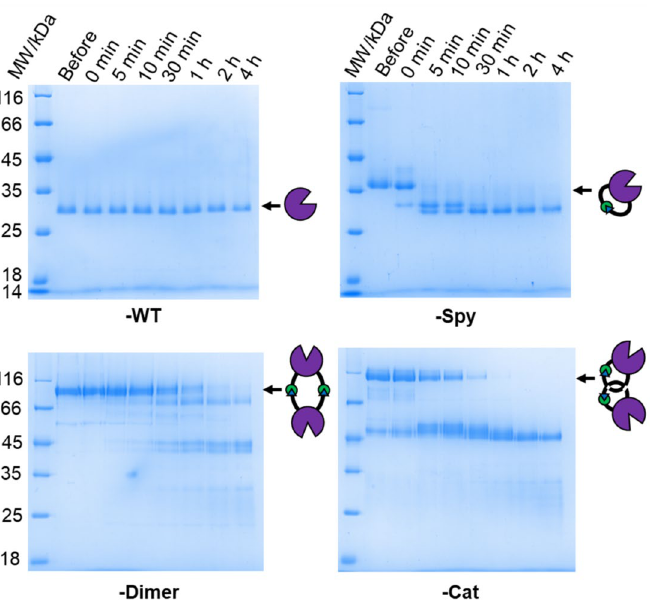
Figure 4. SDS-PAGE analysis of trypsin digest of the linear and cyclic Is PETase variants at 30 °C. 50 mM